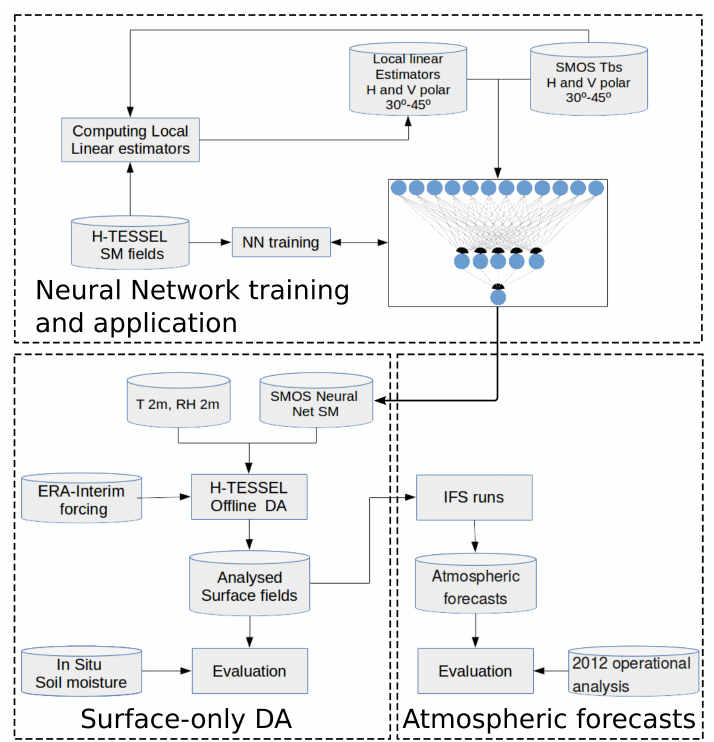
Figure 1. Flow chart of the neural network data assimilation and evaluation